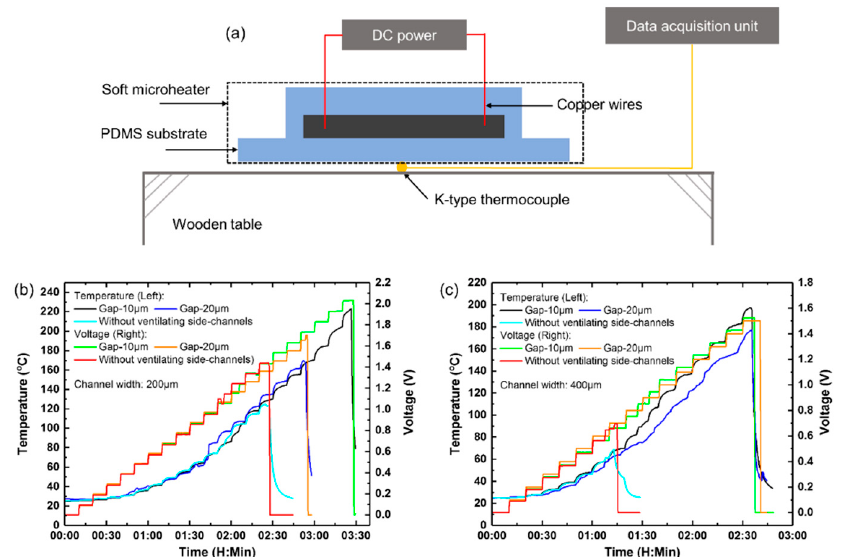
Figure 2. ( a ) Schematic experimental setup for Joule-heat generation and data acquisition. Real-time temperature-voltage characteristic curves of the microheaters with and without the parallel ventilating